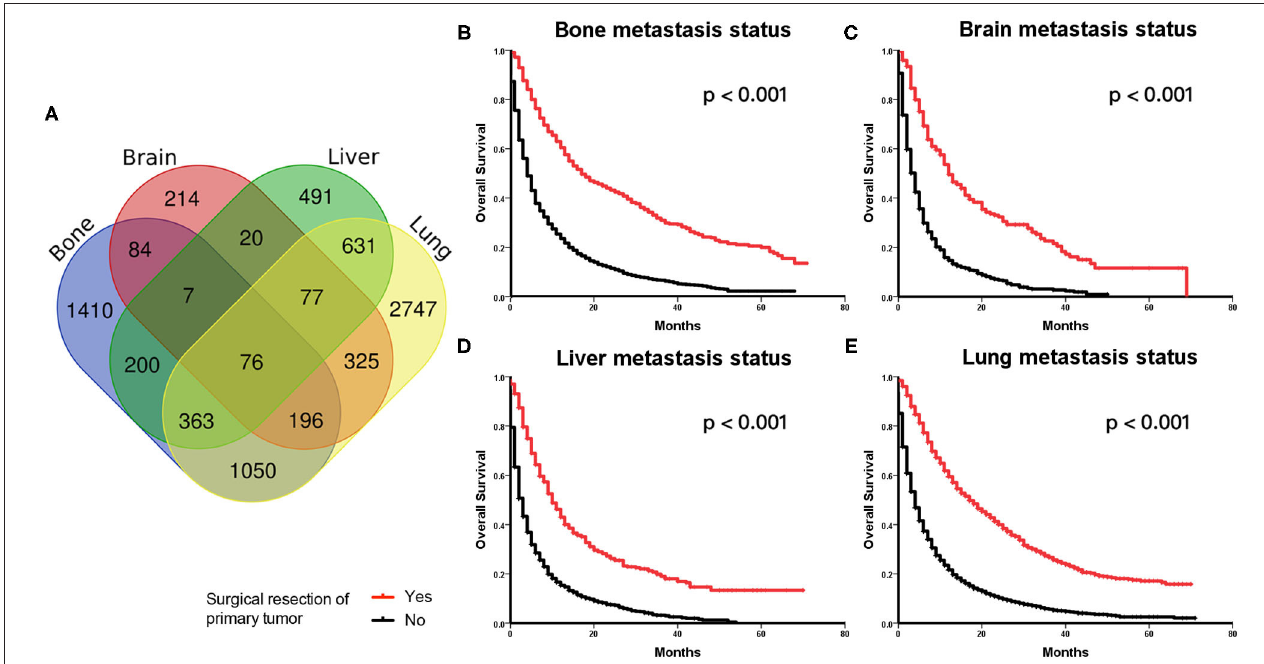
FIGURE 2 | (A) Venn diagram of distributions of main distant metastatic organs in metastatic kidney cancer. (B–E) Kaplan–Meier Curves and log-rank test for the survival analysis in the original cohort. Comparing the overall survival (OS) between the surgery and no surgery groups among patients with bone metastasis status (B) , brain metastasis status (C) , liver metastasis status (D) , and lung metastasis status (E) ,